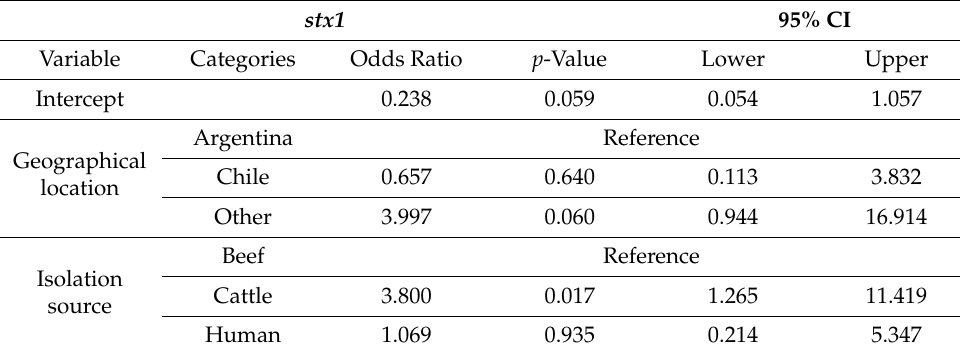
Table 1. Logistic regression models for stx1 and stx1 + stx2 association with geographical location and isolation source of the 130 STEC whole genome sequencing (WGS)